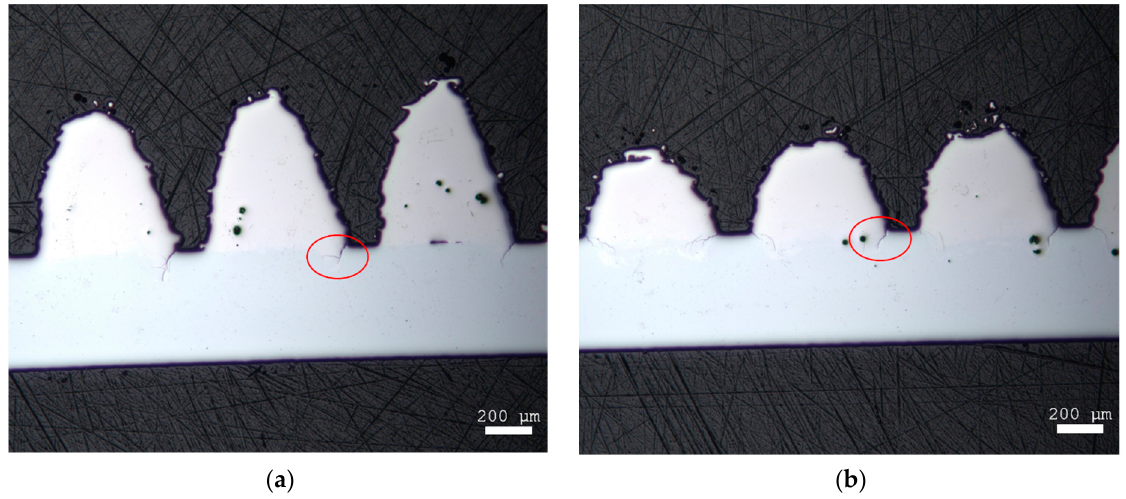
Figure 10. Microscope images of the hybridized NiTi SMA strips ( a ) before and ( b ) after static testing.